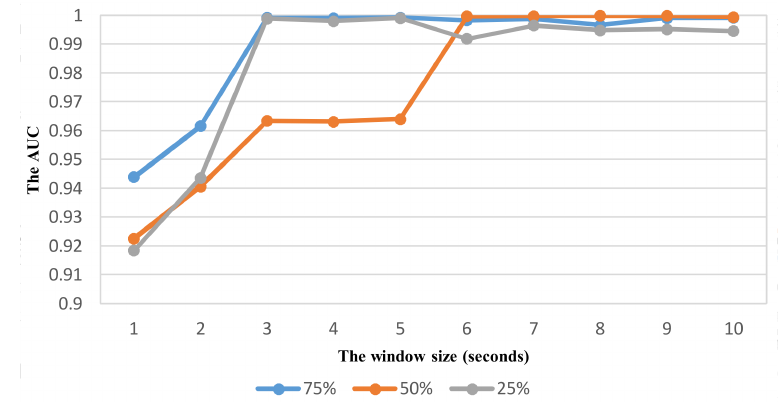
Figure 12. The performance result (AUC) of detecting the activity Stopping with respect to window size and overlapping ratio.